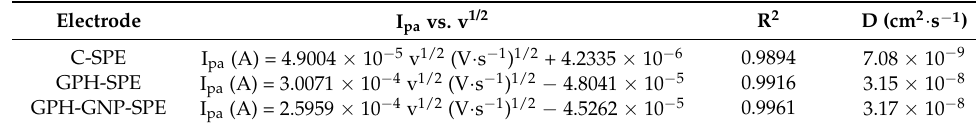
Table 4. The linear fitting equations (Ipa vs. v 1/2 ), R 2 , and D of CGA.